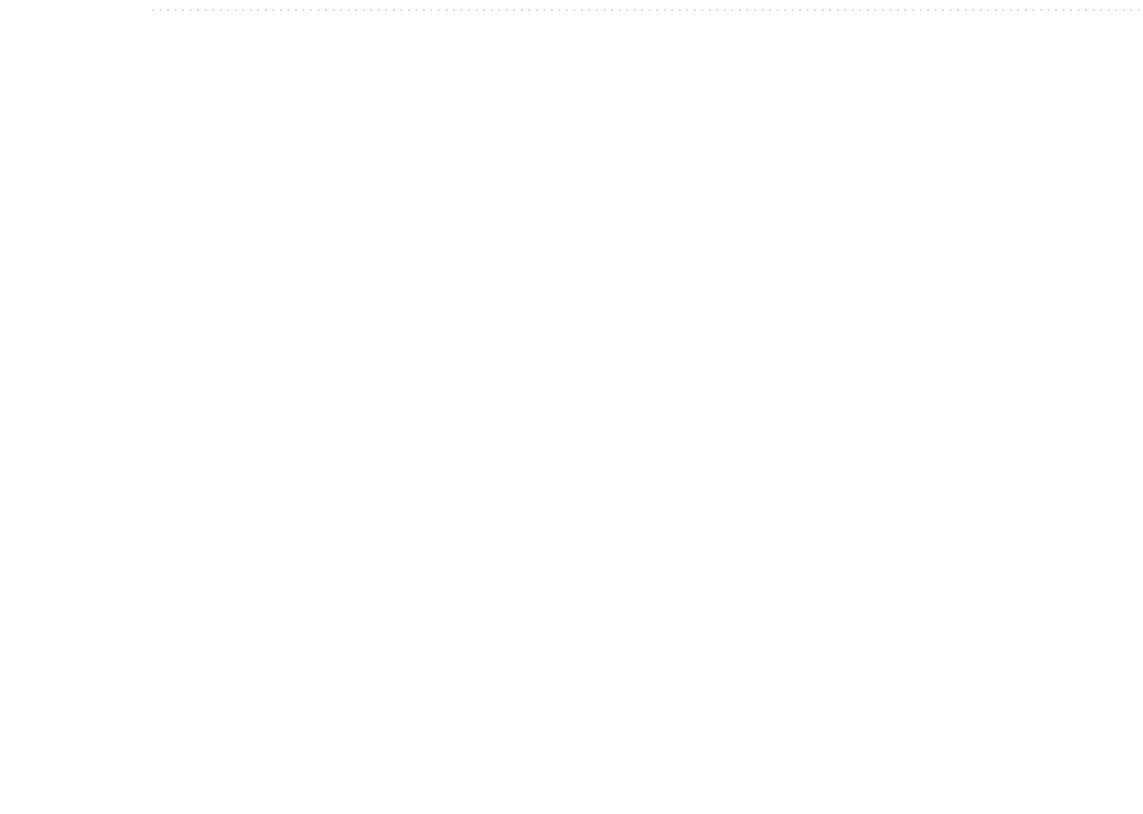
Figure 5. Parameter R 1 , R 2 and Bt effect on magnetic strength profile h (η)